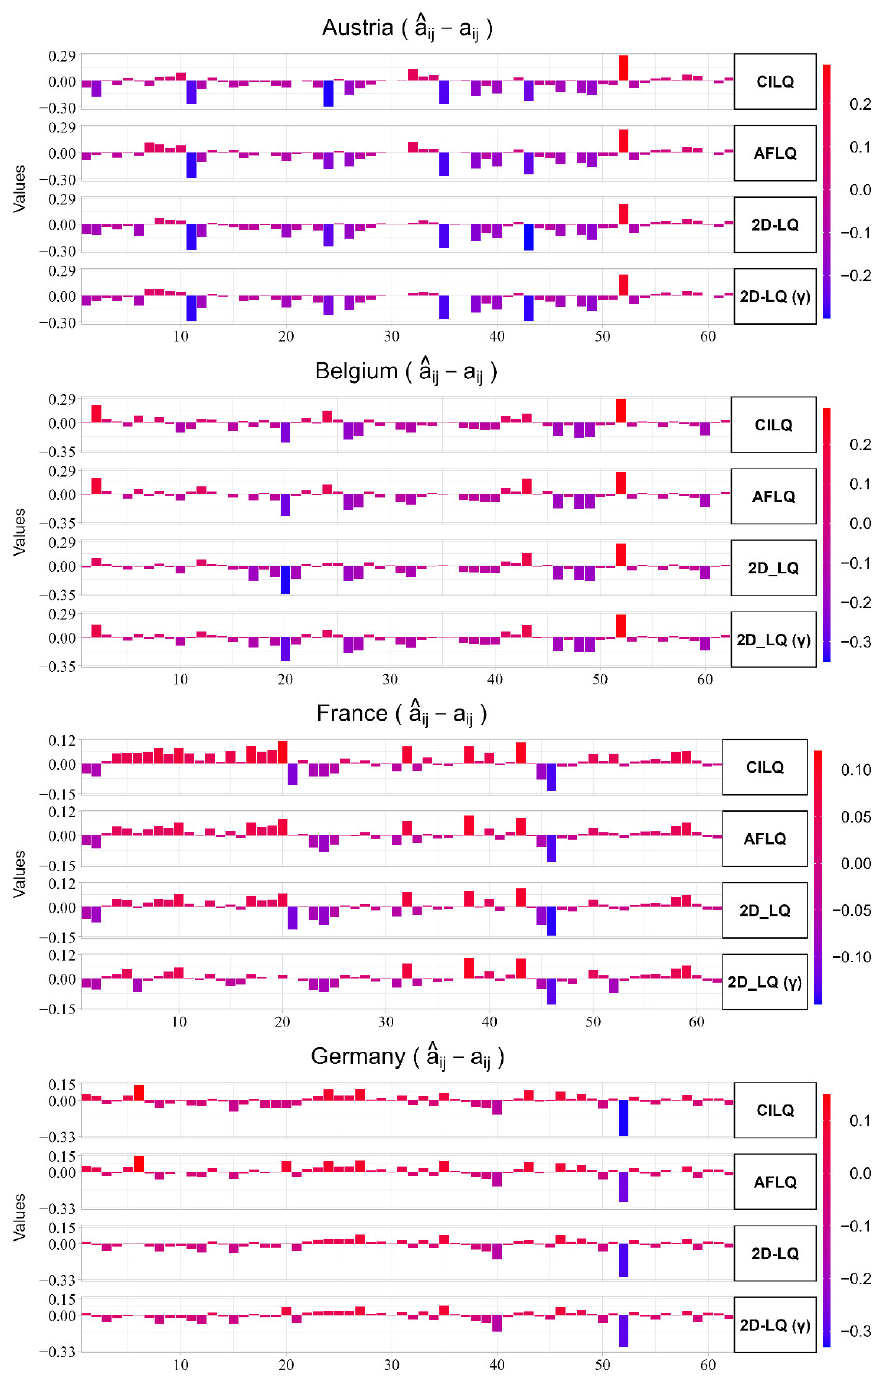
Figure 8. Viewing LQ effects on the main diagonal. Source: internal based on Eurostat data [naio_10_cp1700].